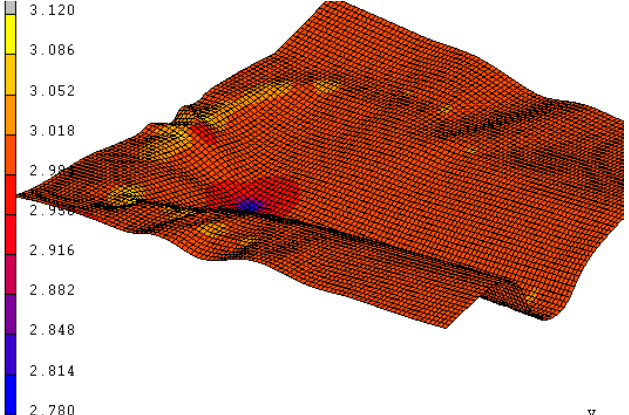
Figure 4. Initial FEM model.